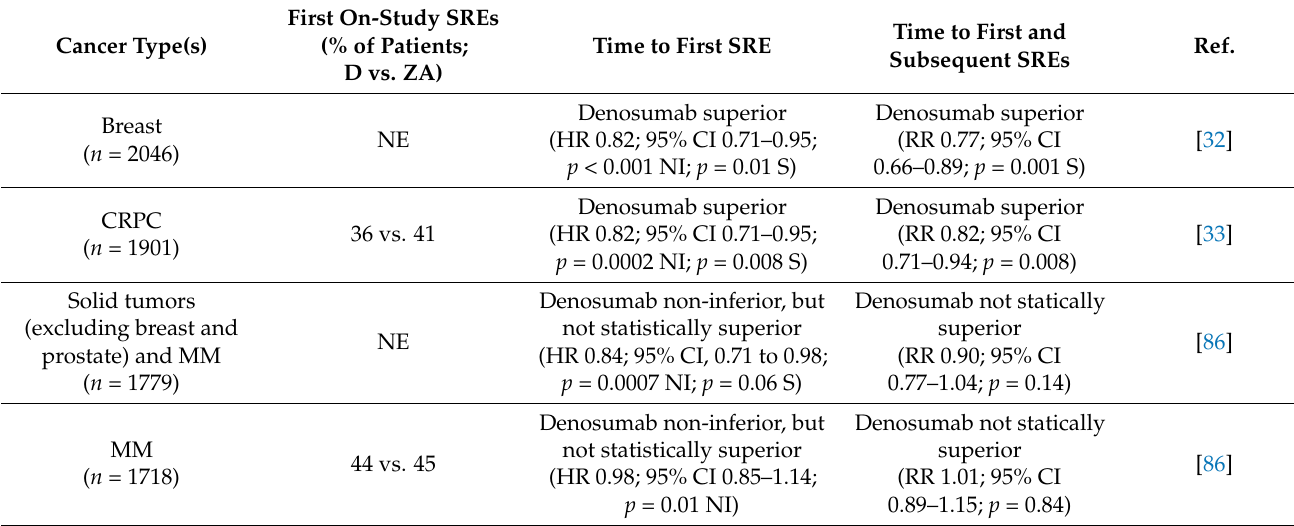
Table 1. Head-to-head randomized controlled trials comparing denosumab with zoledronate for delay or prevention of skeletal-related events in bone metastatic solid tumors and multiple